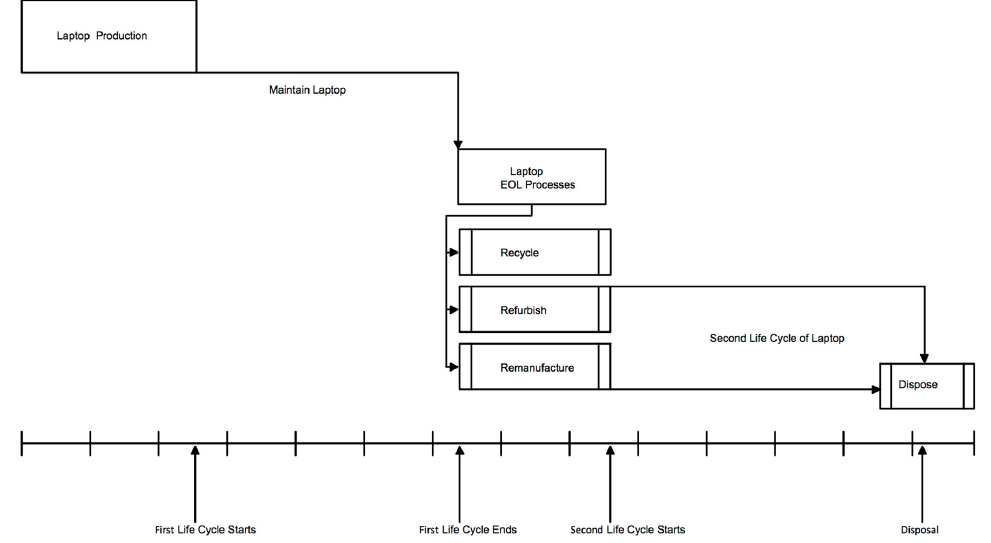
Figure 1. Maintenance and EOL life-cycle scheme of laptops.